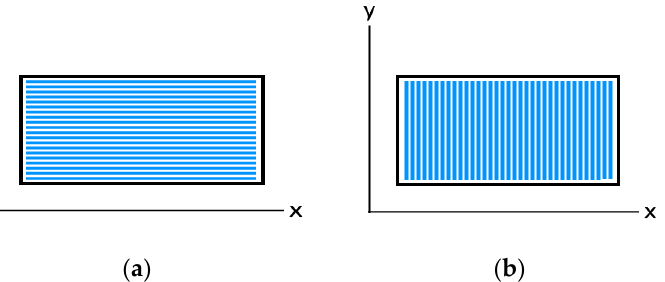
Figure 5. ( a ) Planned printing path for continuous FRP-0°; ( b ) planned printing path for continuous FRP-90°.